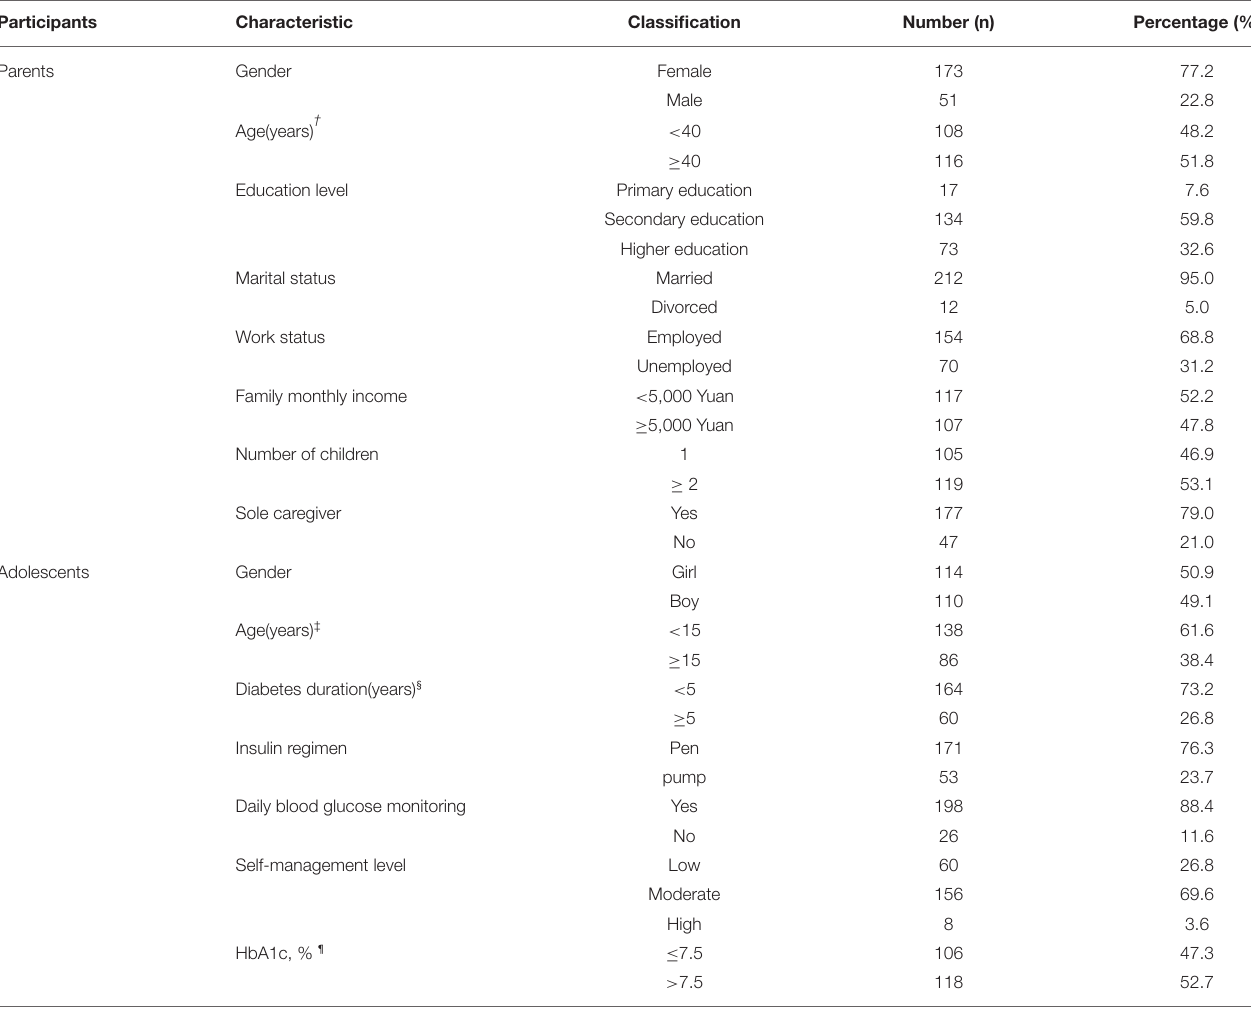
TABLE 1 | Participants’ characteristics.